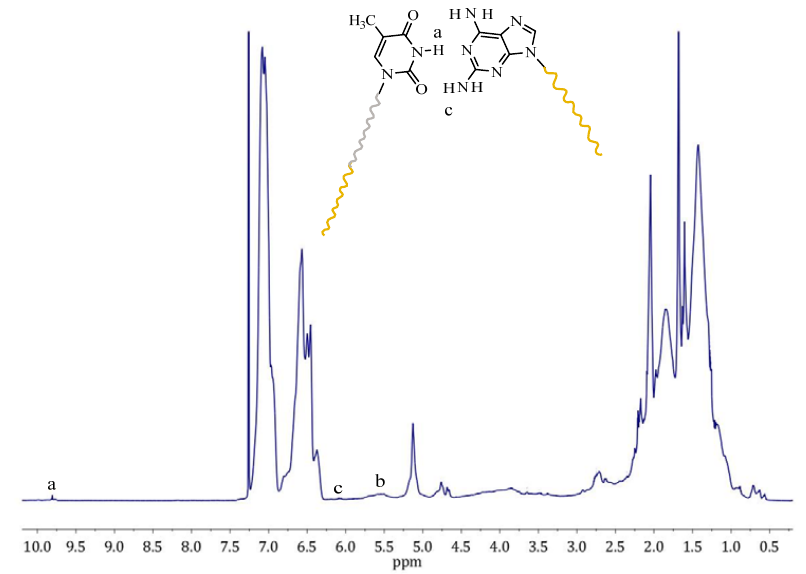
Figure 6. 1 H-NMR spectrum of sample Blend #1. Figure 6. 1 H ‐ NMR spectrum of sample Blend #1. Figure 6. 1 H ‐ NMR spectrum of sample Blend #1.